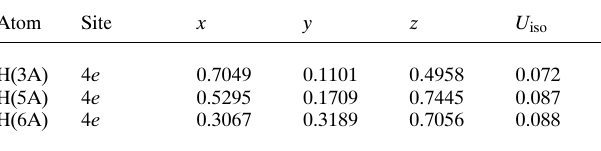
Table 2. Atomic coordinates and displacement parameters (in Å 2 ) . Table 2. Continued